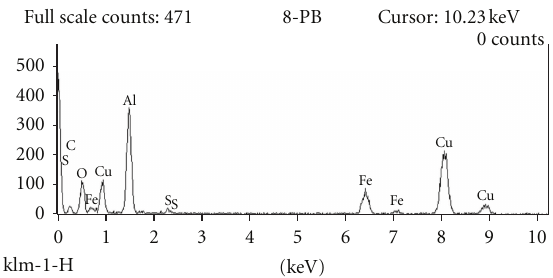
Figure 7: TEM EDS (energy dispersive spectrum) pattern of FeAl particles after corrosion electrochemical